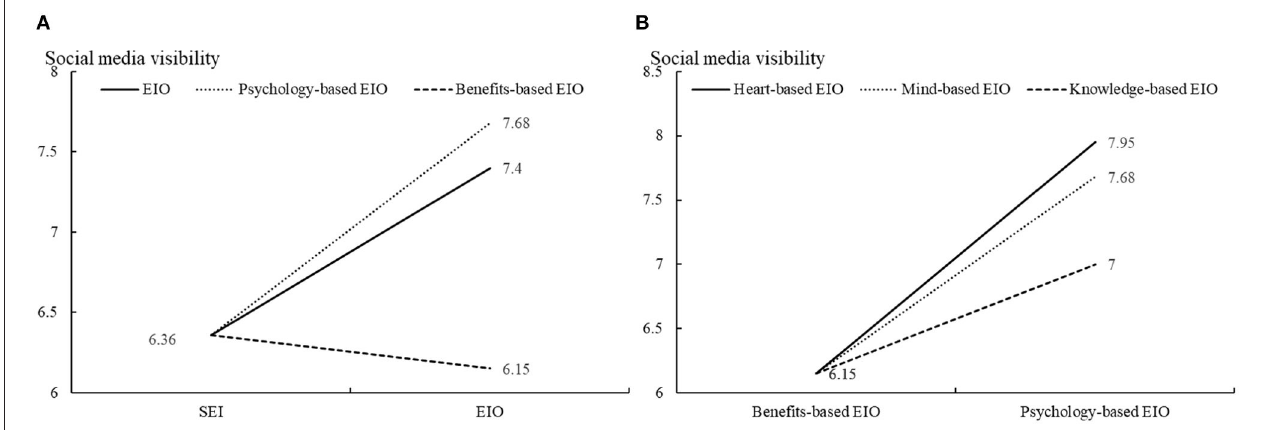
FIGURE 2 | The effect of content optimization strategies on social media visibility. (A) The effect of EIO and SEI on social media visibility. (B) The effect of psychology-based EIO and benefits-based EIO on social media visibility.